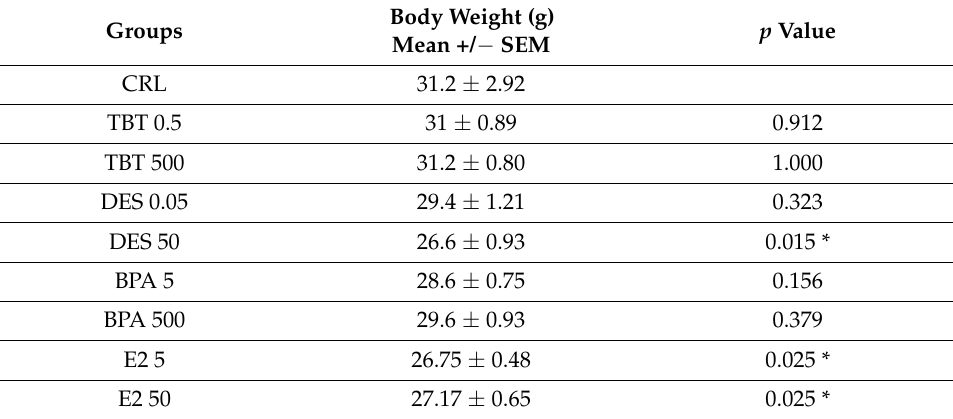
Table 1. Summary of statistical analysis of body weight data. The values (in grams) are indicated as mean ± standard error of the mean (SEM). Bold numbers and asterisks indicate significant differences among the differently treated groups: * p < 0.05, different from control ( p < 0.05, Fisher’s test).